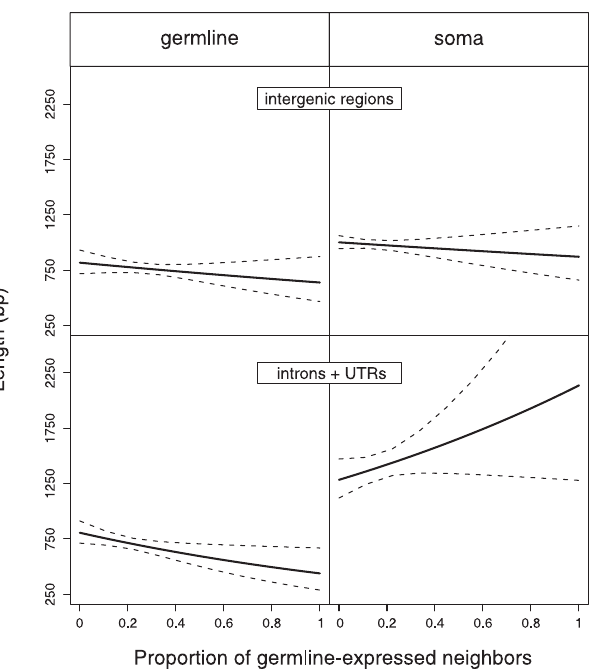
Figure 2. Number of TE Insertions in Intergenic Regions and Genes as a Function of the Proportion of Germline-Expressed Neighbors The figure represents the coefficients ( 6 95% confidence intervals) from the GLM analysis presented in Table 1. The number of TE insertions per gene and intergenic region shown on the y -axis is corrected for the effect of four covariables entered in the GLM (cf., Table 1): recombination rate, intergenic region or intron þ UTR length, proportion of conserved elements, and chromosome (X versus autosomes).